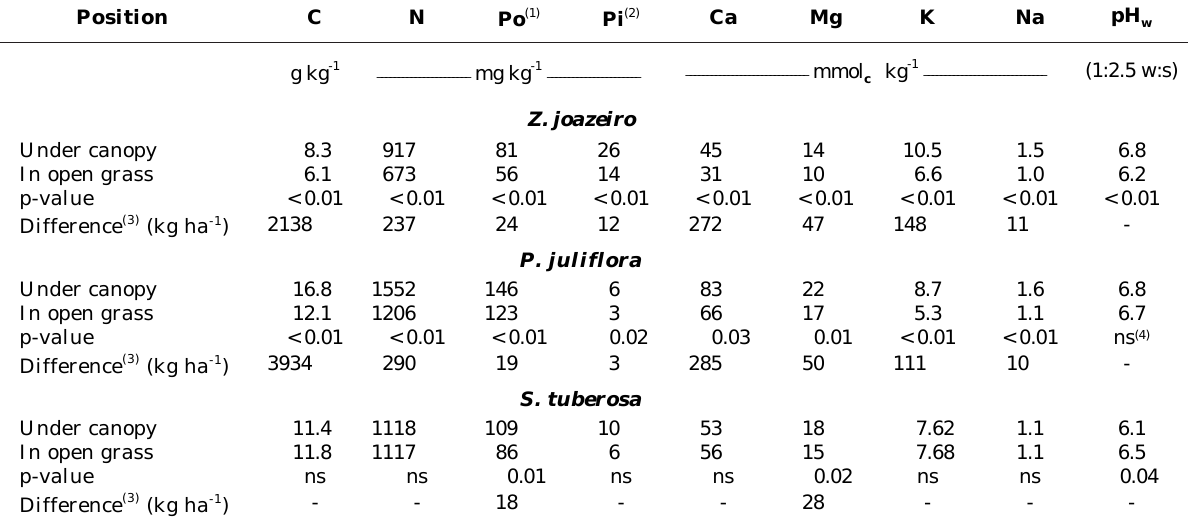
Table 1. Mean values (n = 21) of various soil characteristics (0-15 cm) under and outside the canopy (open grass) of Z. joazeiro , P. juliflora , and S. tuberosa trees and net effect of sample position on soil